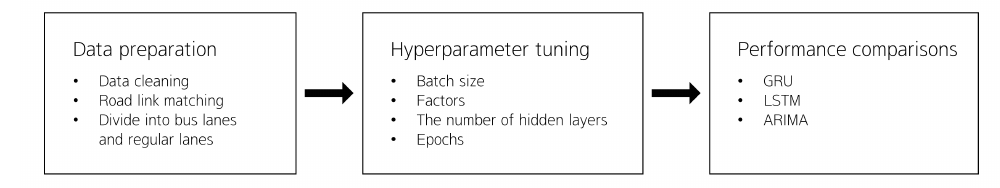
Figure 8. Flow chart of the study.